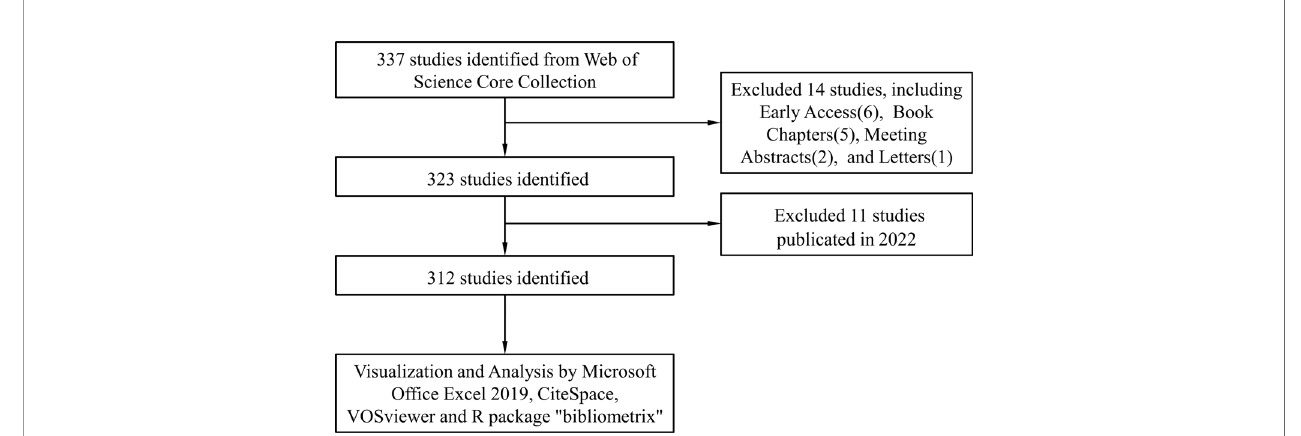
FIGURE 1 | Publications screening fl